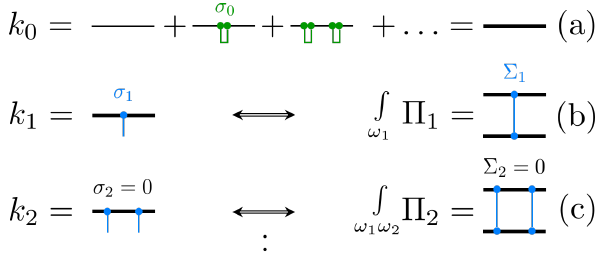
Figure 11: Hierarchy of the Keldysh-operators (left) and conditional propagators (right) for the model (4). The combined infinite-temperature and wideband limit forces all contractions to be instantaneous in time (drawn as vertical) suppressing all vertex correction diagrams. In combination with the bilinearity of the coupling V this causes all self-energies σ and Σ of tier m ≥ 2 to vanish identically, but only after m m integrating over the environment mode energies ω , thereby partially performing i stage